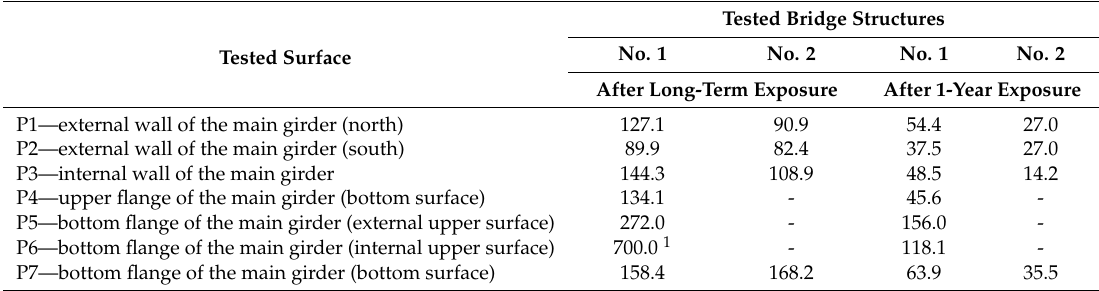
Table 1. Average thickness of corrosion products t corr after long-term and 1-year exposure ( µ m).